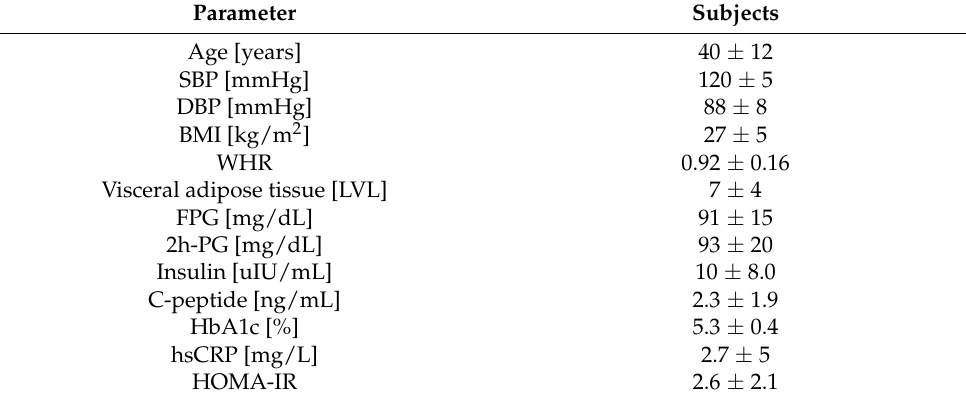
Table 1. Characteristics of the subjects ( n = 30). Data are presented as mean values and their standard deviations. Parameter